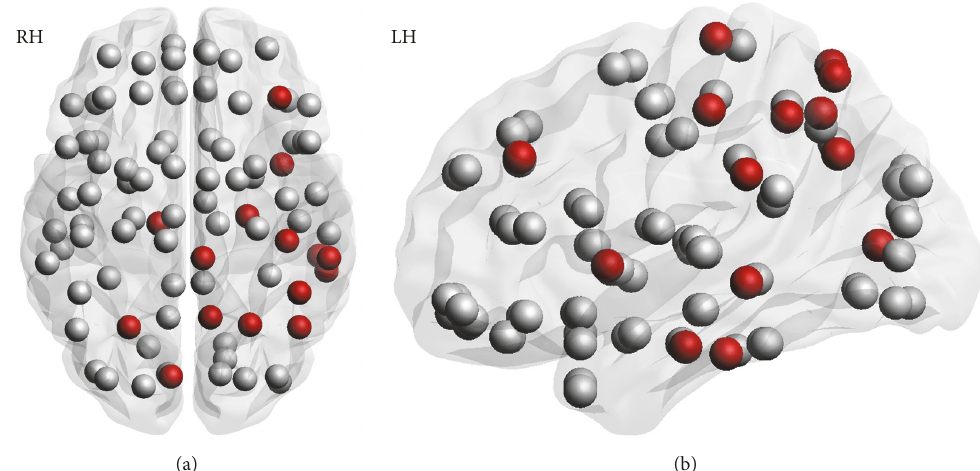
Figure 2: Axial (a) and lateral (b) view of the disconnectivity profile of the patient (obtained from analyzing the DTI-MRI data). Nodes represent 90 cortical and subcortical brain regions [38]. The red nodes indicate regions with more than 1.5 standard deviations of decreased connectivity strength compared to 25 age-matched healthy controls. Note that nodes surrounding the ischemic zone are affected. In addition, however, nodes in the contralesional hemisphere and a frontal node are affected. This suggests that the stroke affected a network of brain